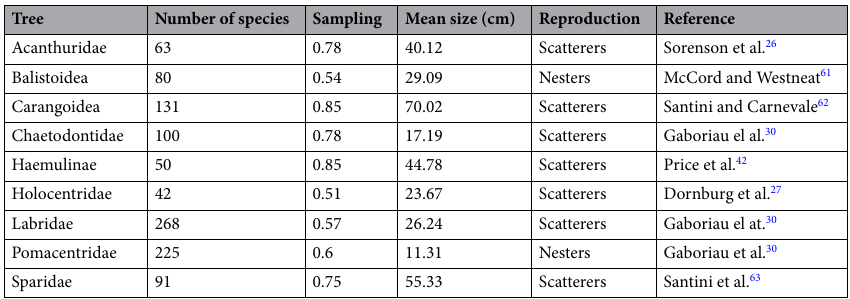
Table 4. Coral-reef fish phylogenies included in the analysis. The Number of species is the number of species present in the phylogenetic tree. The Sampling column represents the phylogenetic